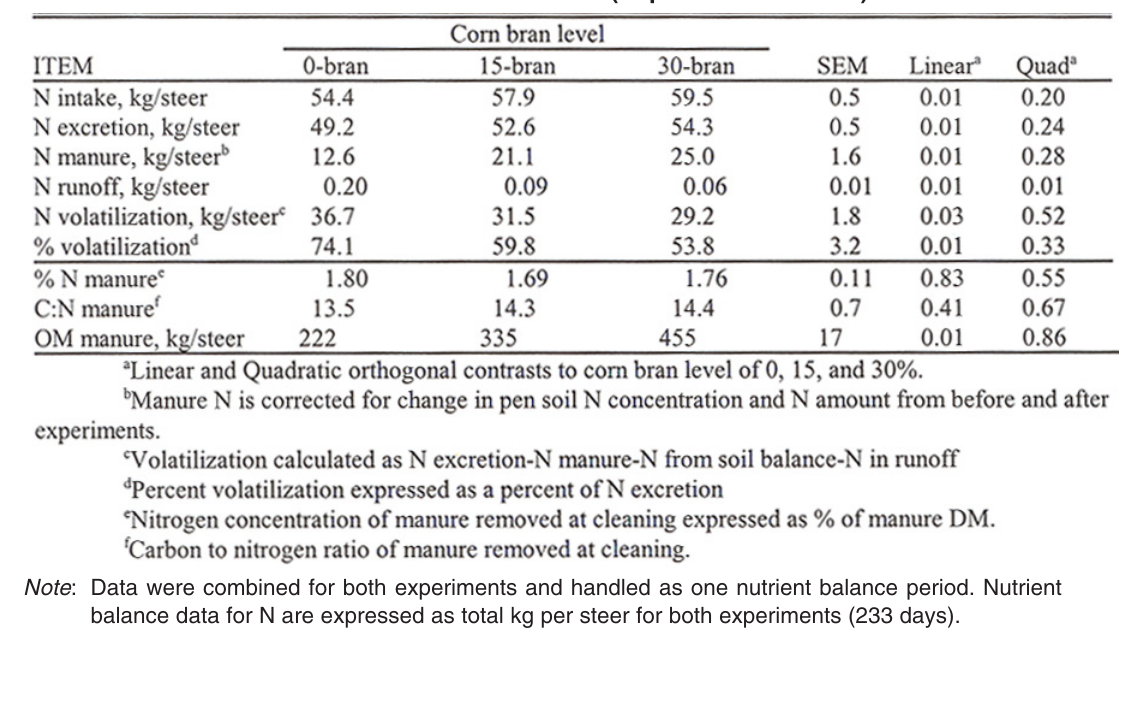
Effects of Dietary Corn Bran on N Balance in the Feedlot and